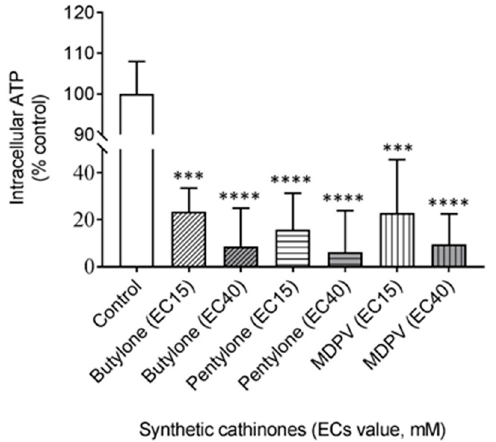
Figure 5. Intracellular levels of adenosine triphosphate (ATP) after 24 h of treatment of EC 15 and EC 40 for butylone, pentylone, and MDPV. Data are Mean ± SD obtained from three independent experiments normalized to total protein. Different to the control; *** p < 0.001 and **** p < 0.0001.